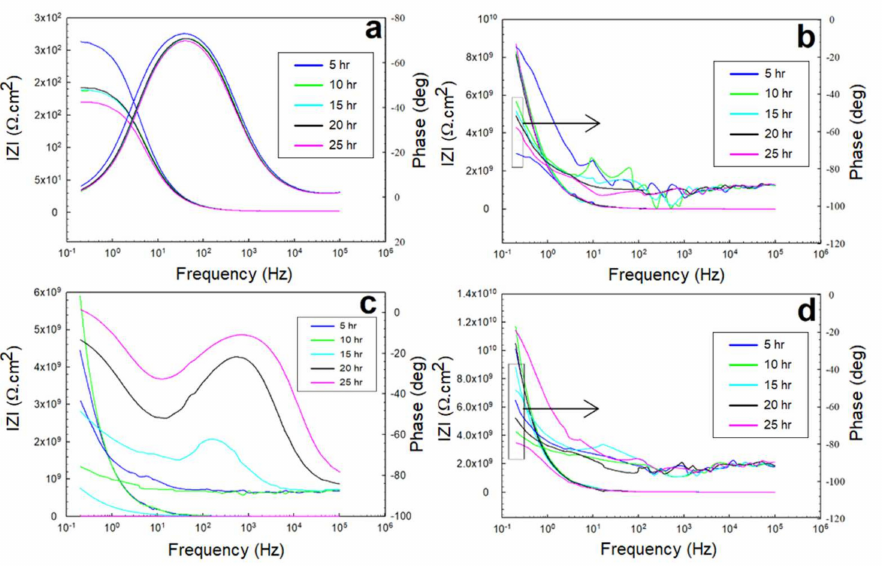
Figure 13. EIS Bode plots of the 0.5 M H 2 SO 4 solution for: ( a ) exposed steel, ( b ) glass/epoxy, ( c ) Kevlar/epoxy, and ( d ) epoxy